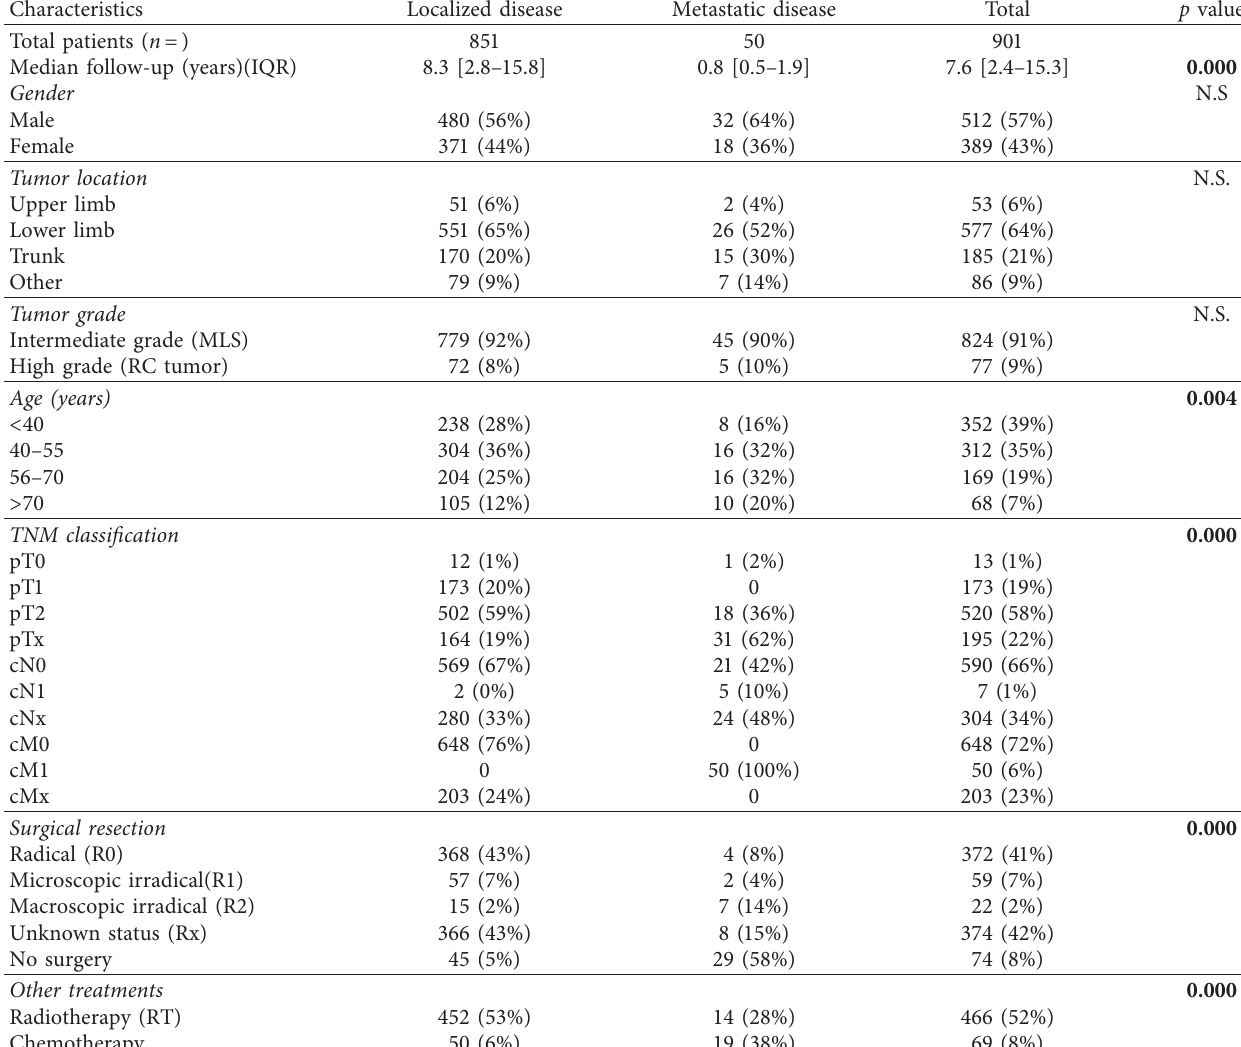
Table 1: Baseline characteristics of patients with localized and metastatic disease at